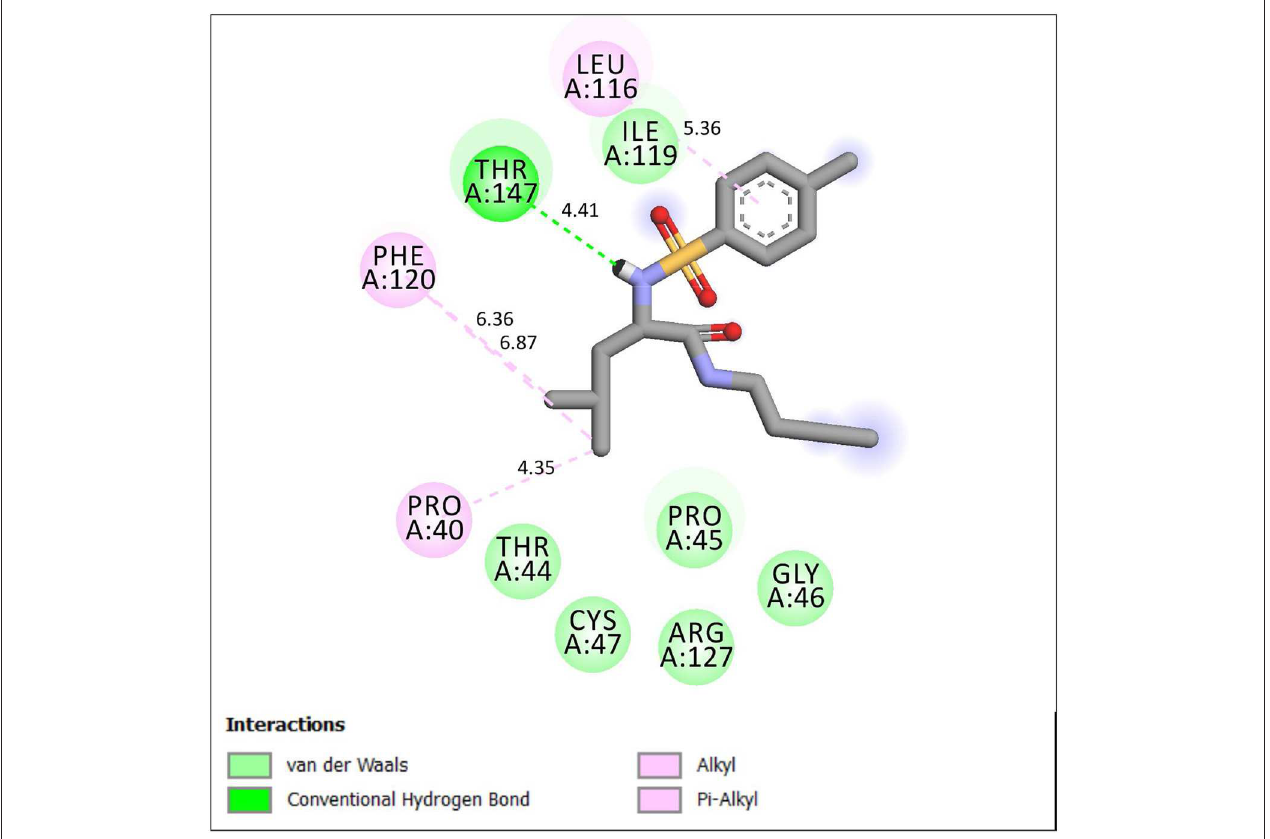
FIGURE 2 | 2D representation of binding interaction of compound 4e and the amino acid residues of 1HD2.